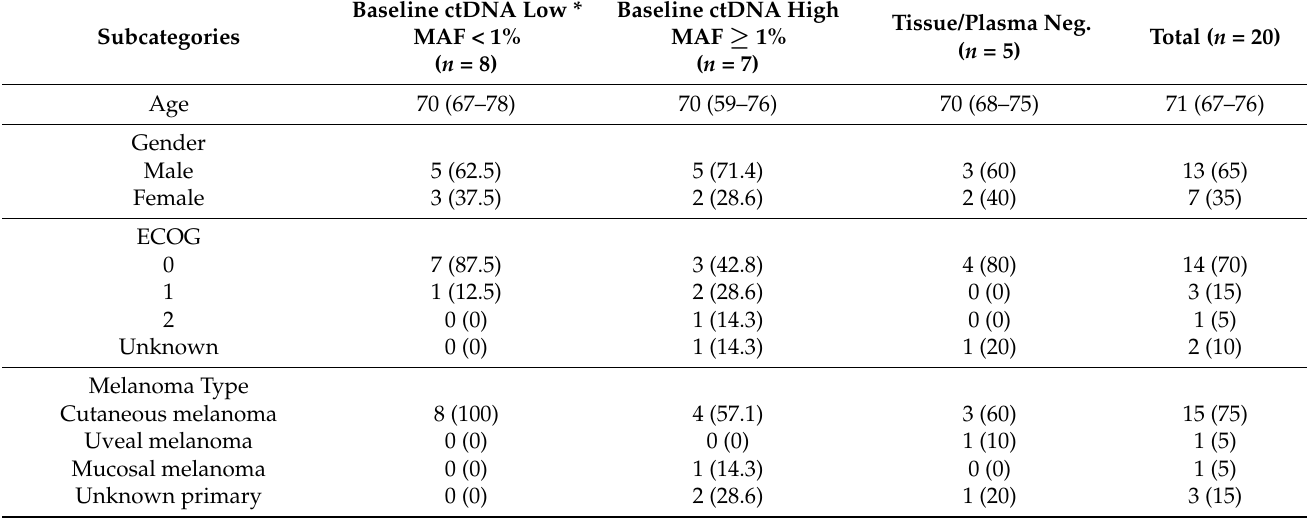
Table 1. Baseline patient characteristics of cohort ( n = 20).